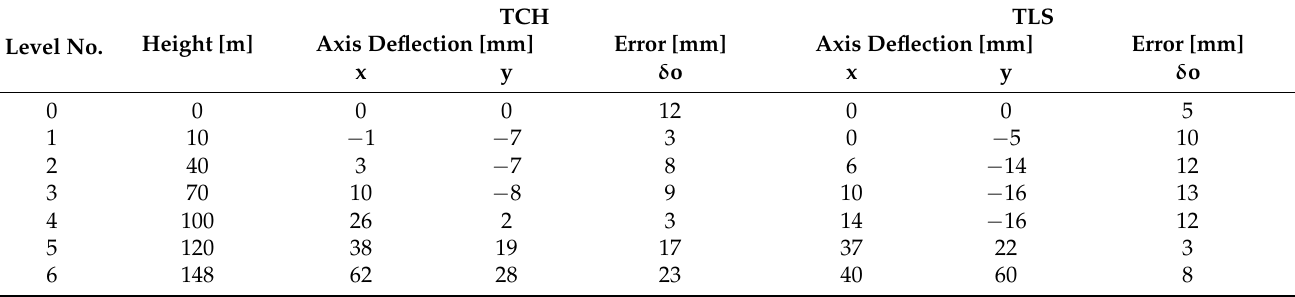
Table 3. Horizontal deflections of the wind turbine